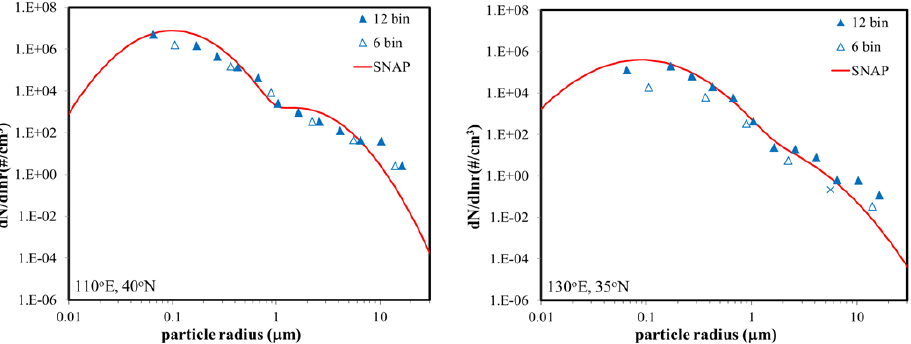
Figure 13: Dust particle size distribution calculated with SNAP (red curve), 12-bin scheme (filled triangles) and 6-bin scheme (empty triangles) at two selected locations (geographical coordinates given in the lower left corner) in Fig. 12.